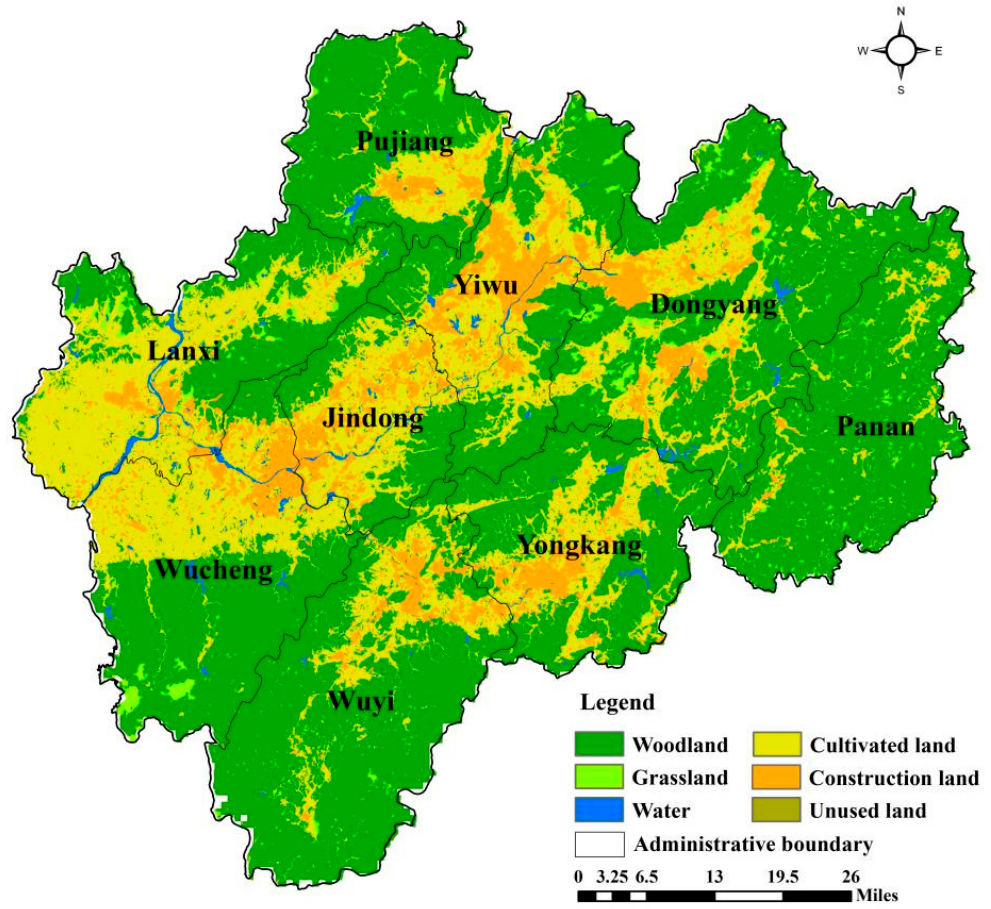
Figure 6. Optimized land-use spatial pattern in 2030.